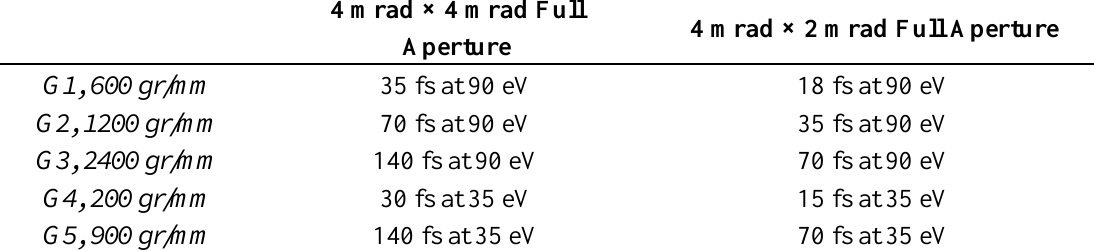
Table 2. Time response of the OPM monochromator for a beam aperture of 4 mrad × 4 mrad and 4 mrad × 2 mrad, calculated as the half-width spread of the optical paths at the output slit.